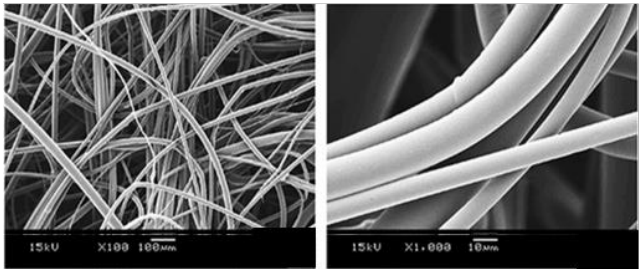
Figure 17. SEM images of carvedilol coating microfibres. Reproduced with permission from [152], copyright 2015 Elsevier. copyright 2015